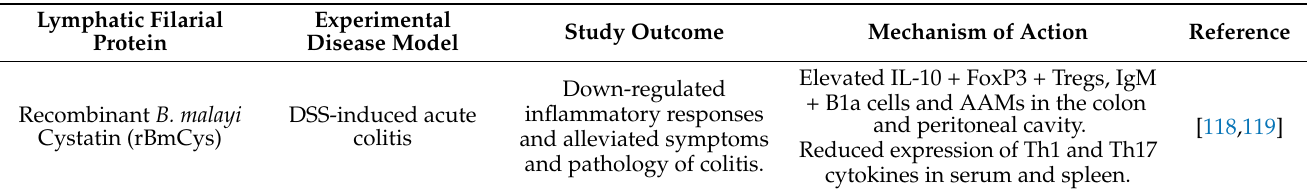
Table 2. Human lymphatic filariae-derived molecules as a therapy against inflammatory diseases. Lymphatic Filarial Experimental Protein Disease